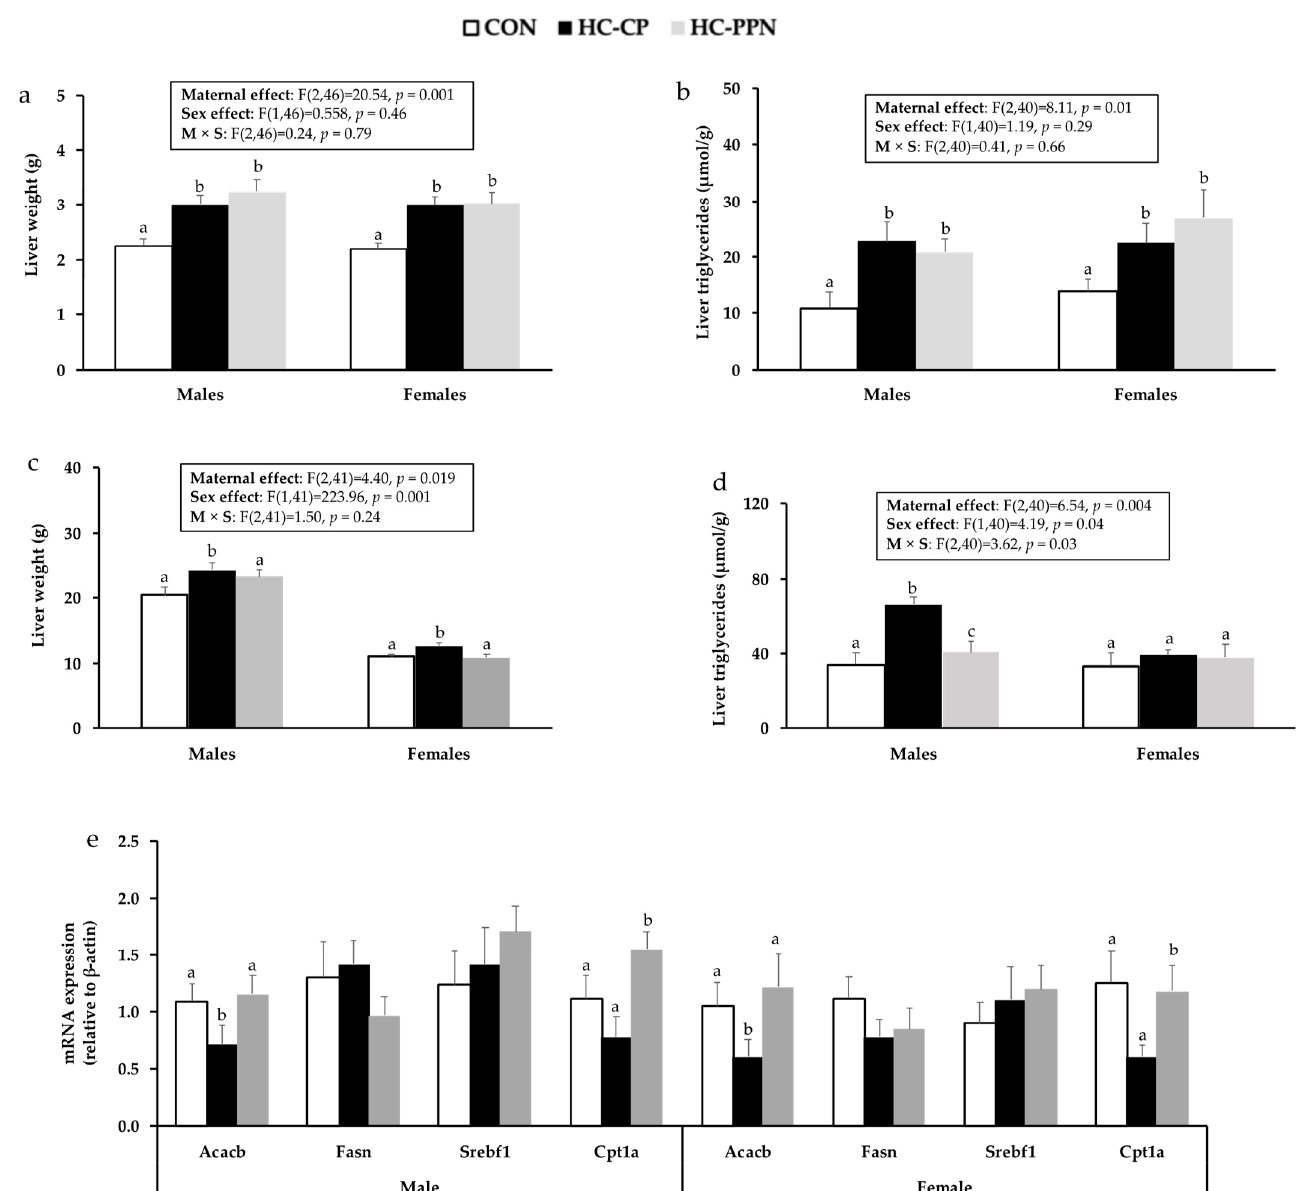
Figure 4. Liver outcomes in male and female offspring from CON, HC, and HC-PPN mothers including liver weights and triglyceride concentration in newly weaned ( a , b ) and adult ( c , d ) offspring; mRNA expression of lipid-regulatory targets in adult offspring ( e ). CON, low-calorie control diet; HC-CP, high-calorie obese-inducing diet with casein protein; and HC-PPN, HC high-calorie diet with supplemental yellow pea protein (25%). Maternal (M), sex (S), and interaction (M × S) were analyzed using two-way ANOVA with LSD post hoc test ( p < 0.05). abc Treatment groups within sex that do not share a superscript are significantly different ( p < 0.05). Data are means ± SE, and n = 7–9 mothers per group.